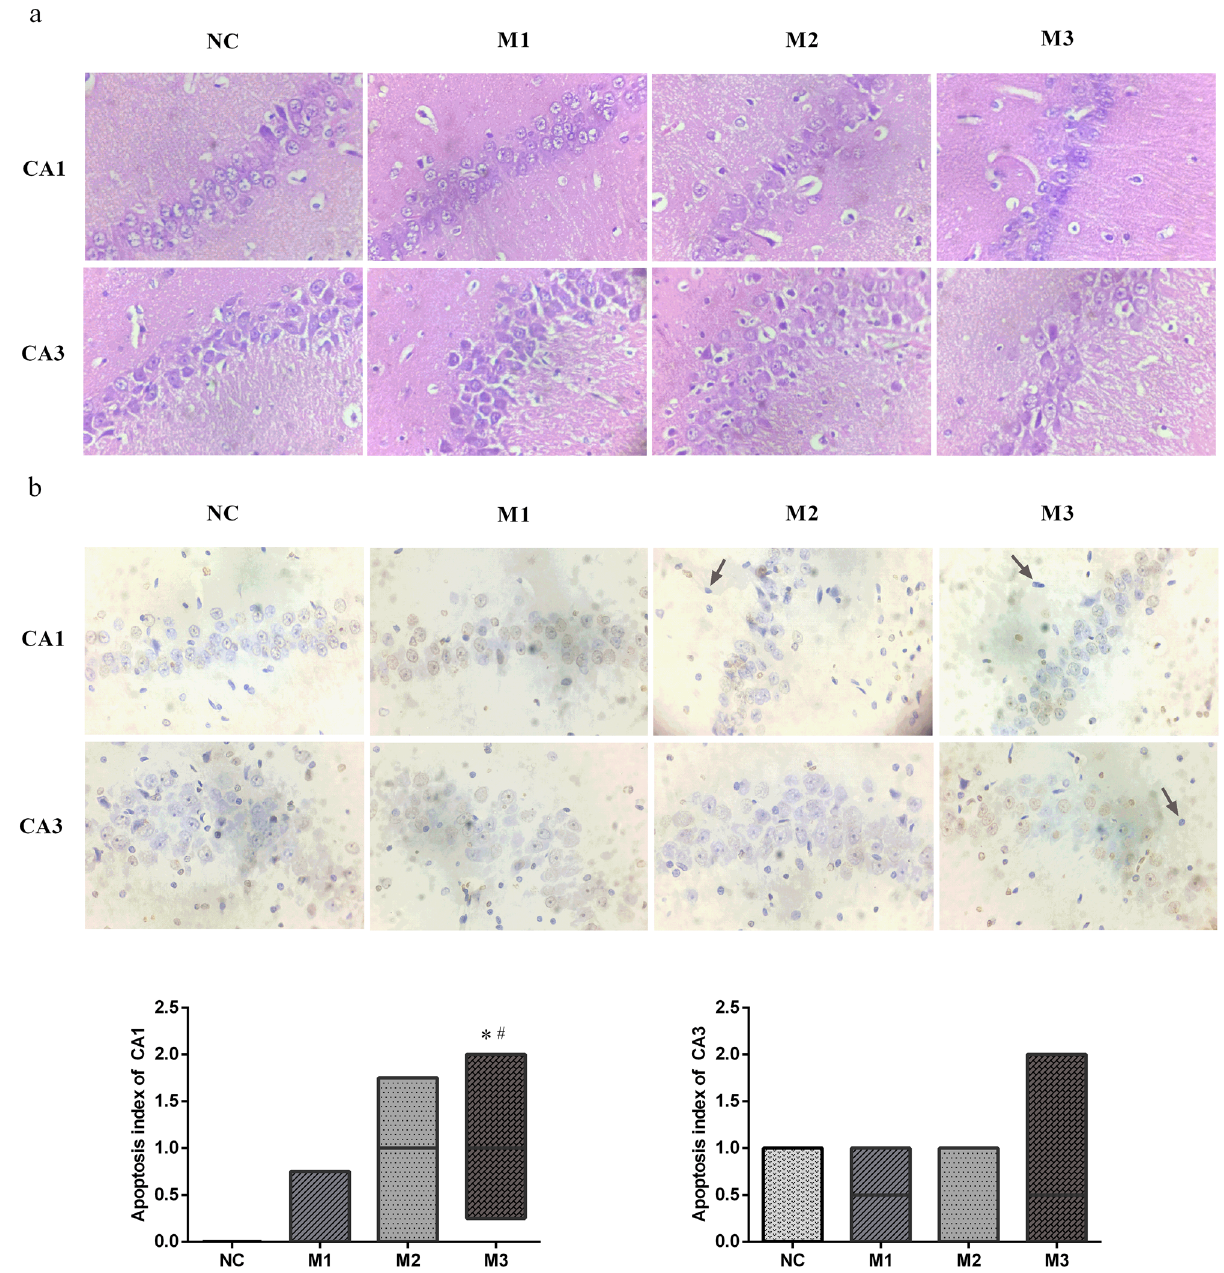
Figure 2. The pathological changes of hippocampal CA1 and CA3 regions of rats. ( a ) Haematoxylin–eosin staining, × 400. ( b ) terminal deoxynucleotidyl transferase nick end labelling, × 400. Apoptotic bodies were marked with arrows. Data performed as median (25th percentile, 75th percentile), n = 8 for each group. *P < 0.05 compared with the NC group, # P < 0.05 compared with the M1